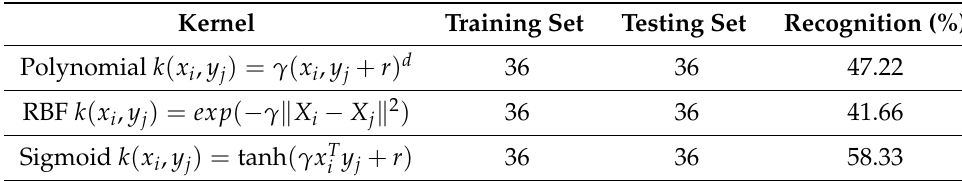
Table 5. MVPR using different kernels and D 2 from Y .